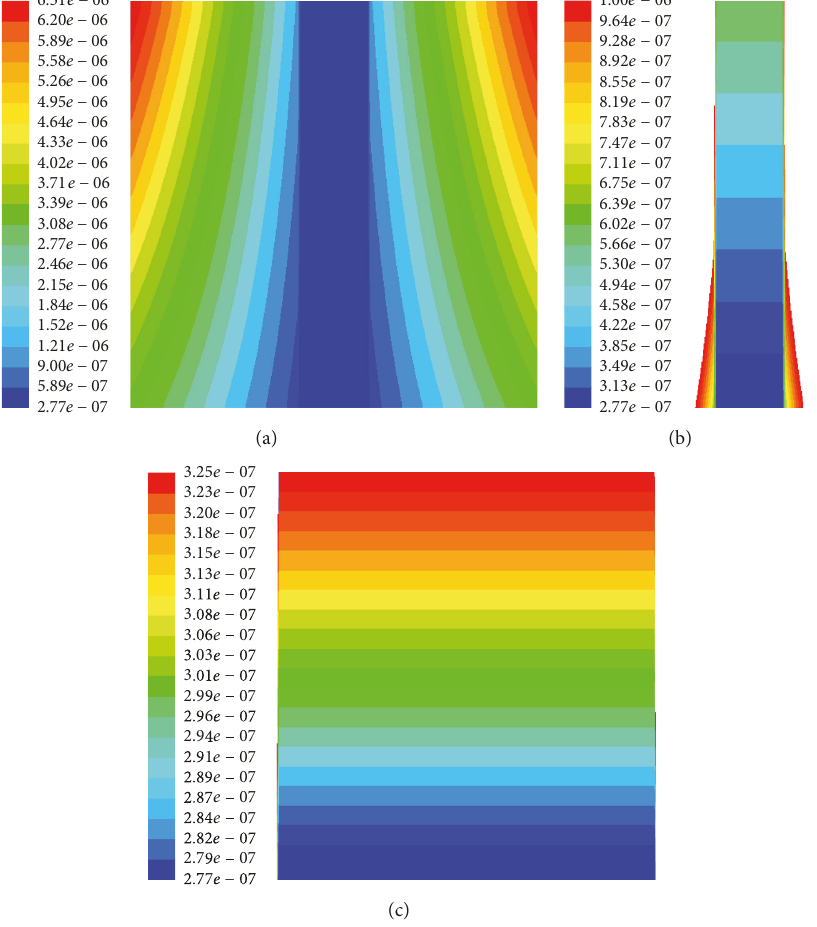
Figure 1: Cell volume contour in m 3 for mesh M (a) midplane, (b) center region of the midplane (30cm width versus 180 cm height), and (c) lower burner zone of the midplane (30cm width × 30 cm height).